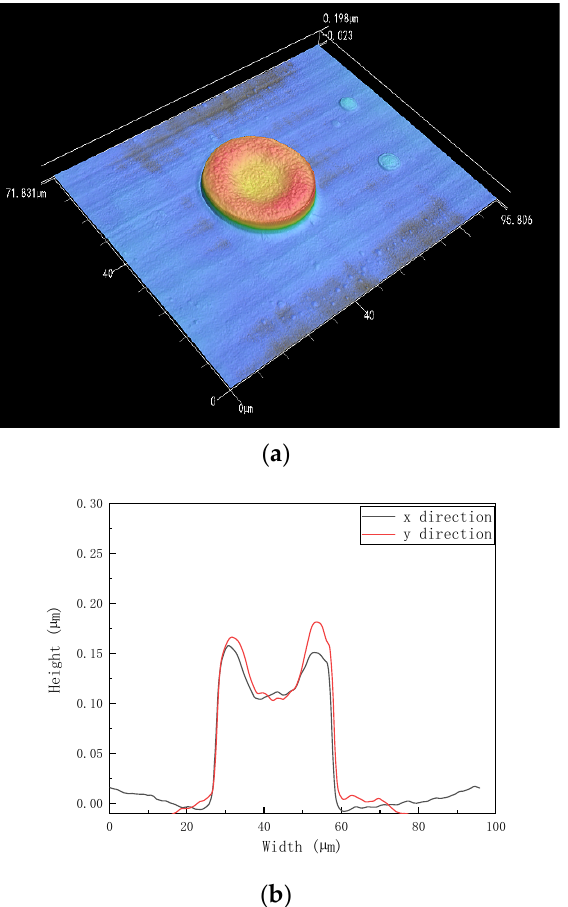
Figure 2. ( a ) PDMS polymer dot, formed by an inkjet print droplet of 10 mg/mL PDMS in decane on sapphire; ( b ) Cross-sections of the PDMS dots in the x-direction and y-direction.